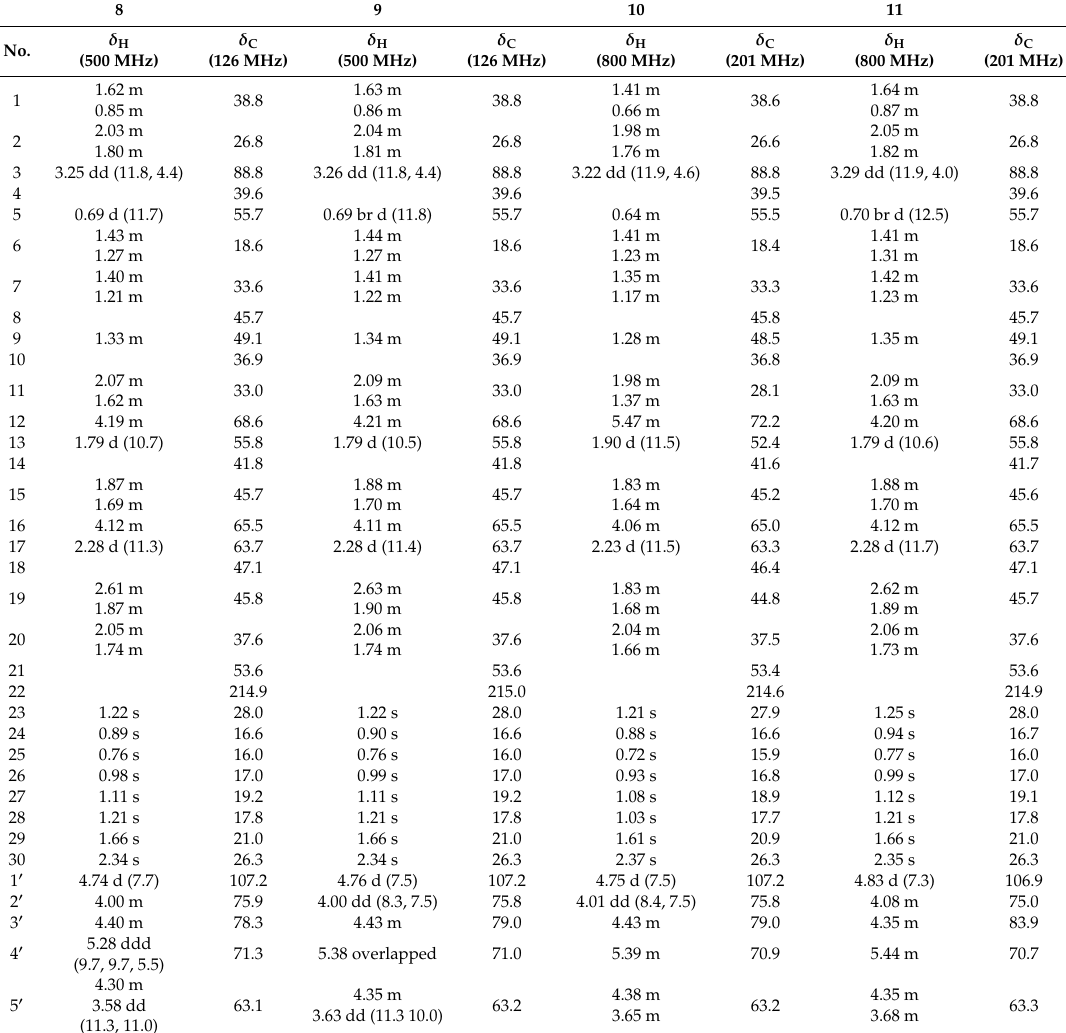
Table 4. 1 H and 13 C-NMR data of 8 – 11 in Pyridine- d 5 ( δ in ppm, J in